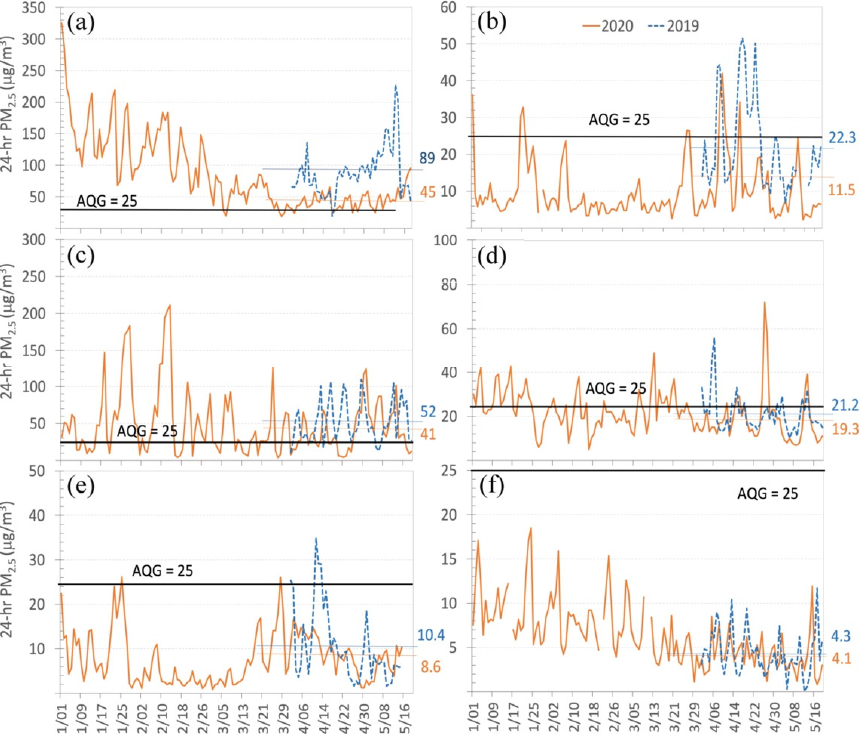
Figure 3. Comparisons of daily 24-h PM 2.5 air quality, between 2019 and 2020, during COVID-19, for the selected cities: ( a ) New Delhi; ( b ) London; ( c ) Beijing; ( d ) Hong Kong; ( e ) Zurich; ( f ) New York. The black (solid), blue (dash), and orange (solid) lines represent the AQG standard, PM 2.5 concen- tration from 2019, and PM 2.5 concentration from 2020, respectively.